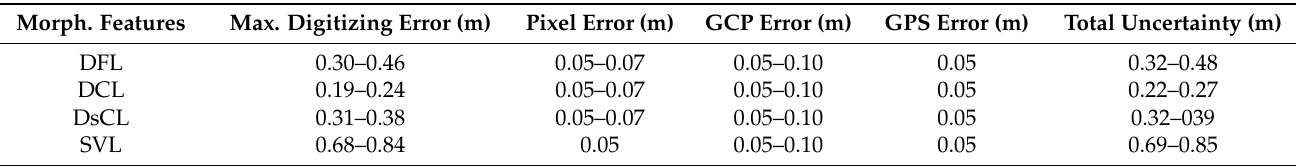
Table 6. Uncertainty values for each geomorphic line feature. Total uncertainty calculated as the RMSE of four different sources of error.